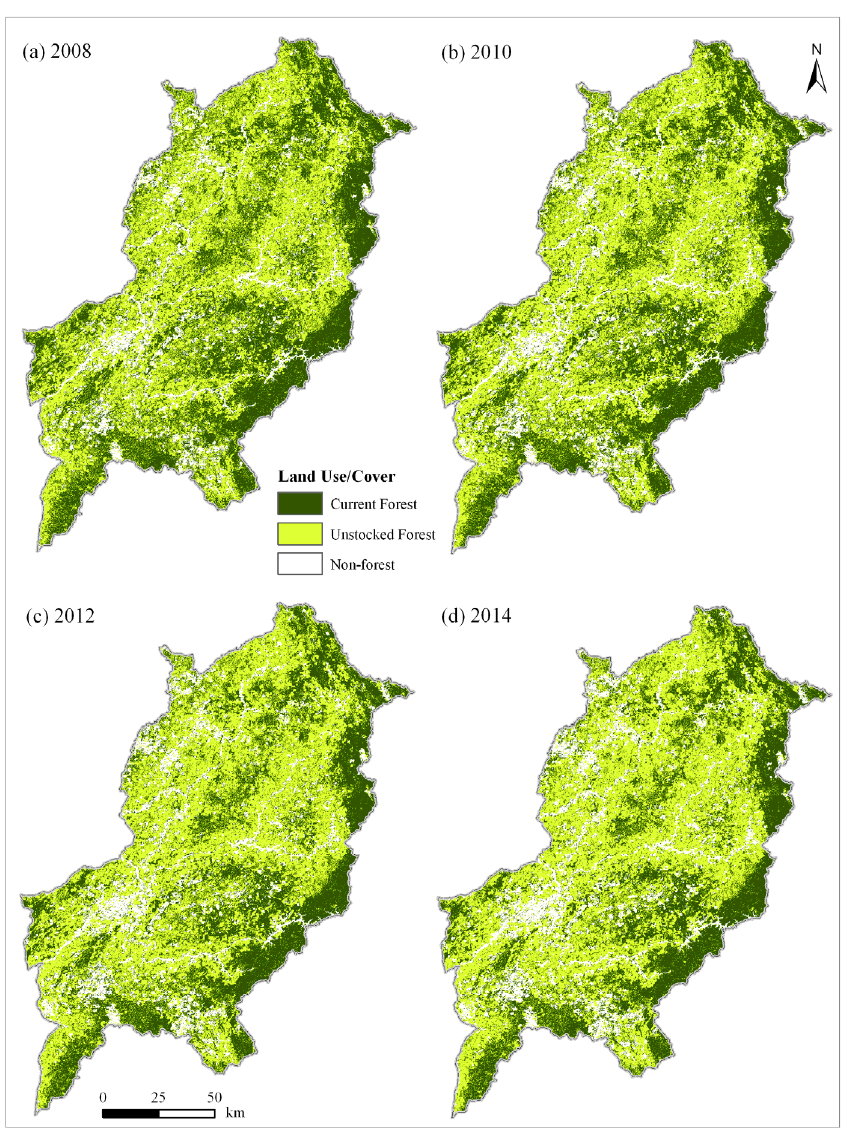
Figure 9. Simulations under the pessimistic